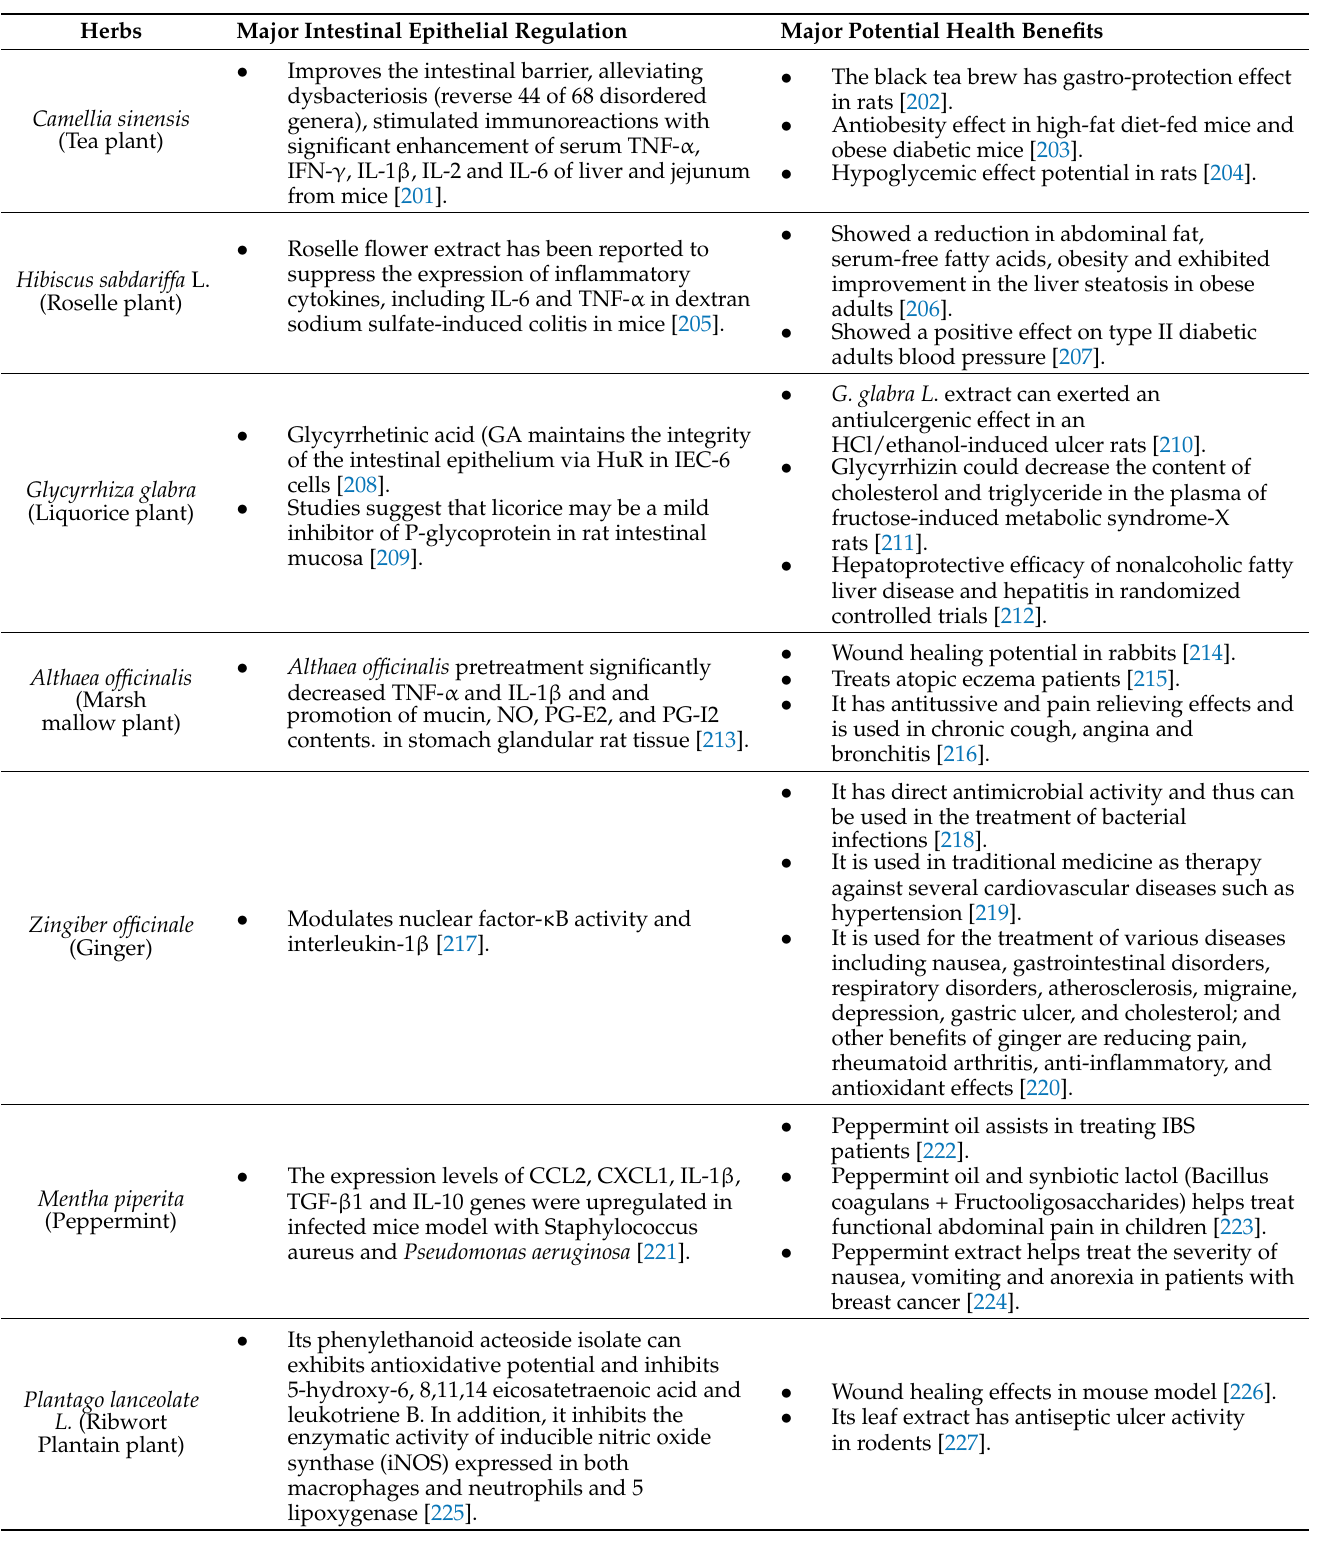
Table 3. Major herbs that help leaky